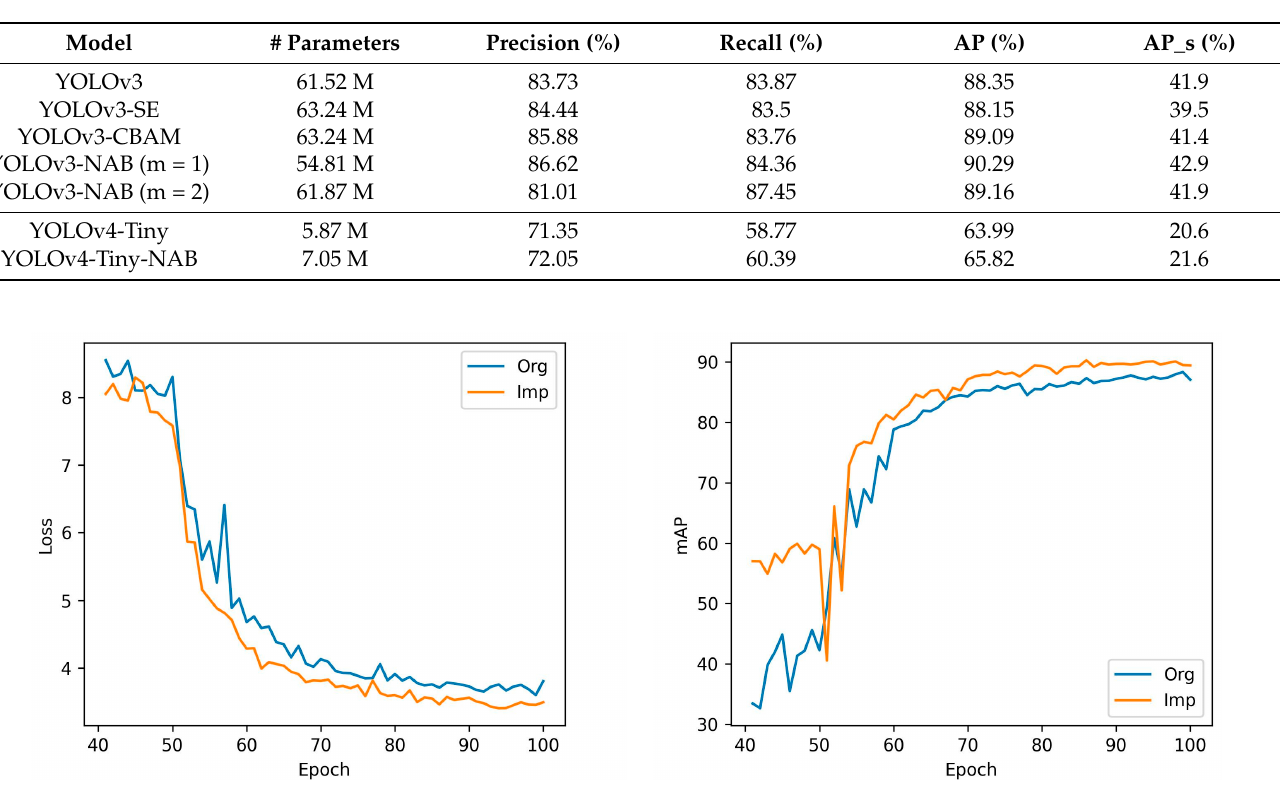
Figure 9. The loss and mAP curves of YOLOv3 and YOLOv3-NAB (m = 1). ‘Org’ and ‘Imp’ denote YOLOv3 and YOLOv3-NAB (m = 1), respectively.